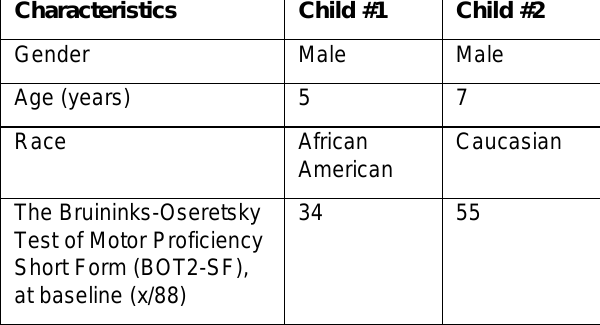
Table 1. Characteristics of the Child Participants